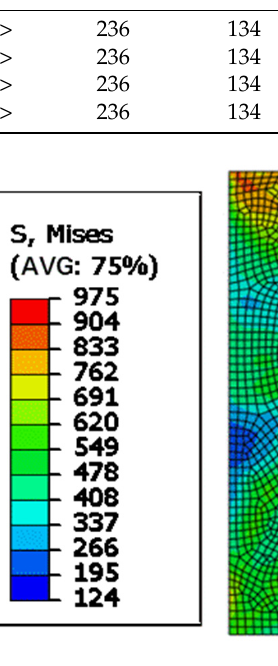
Figure 7. The stress field of the tensile model at − 100 °C . Table 3. Material parameters used in the simulation model.